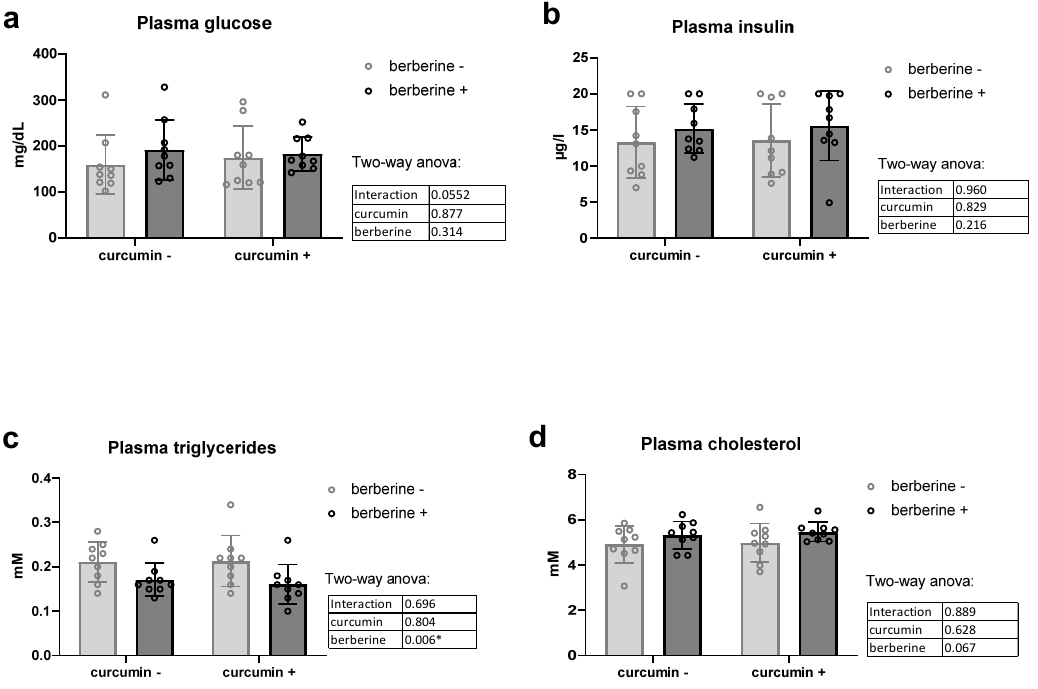
Figure 3. Lipid profile and glucose homeostasis of ob/ob mice fed a standard diet supplemented with or without berberine or curcumin for 4 weeks ( n = 9 for each group). Plasma glucose ( a ), plasma insulin ( b ), plasma triglycerides ( c ), plasma cholesterol ( d ) * p < 0.05 for berberine effect (two-way ANOVA).